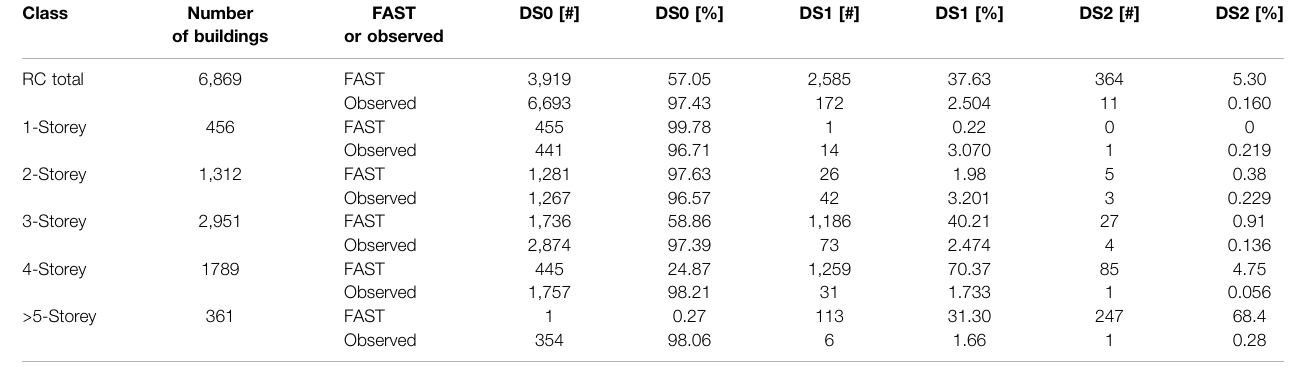
TABLE 2 | Damage state by building height using FAST-NEPAL for Ward-35 buildings. Class Number of buildings